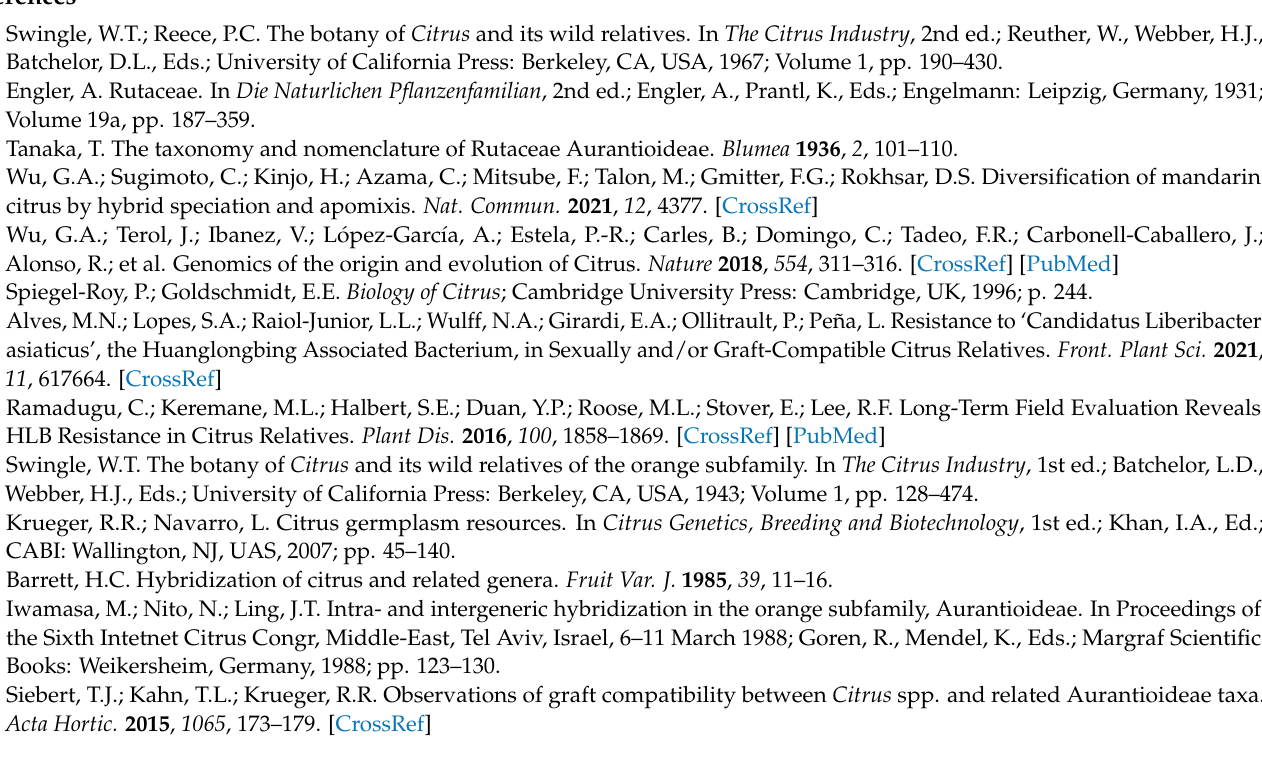
grafting. Figure S2: Plants of (left) Rangpur lime grafted on Clausena lansium , and (right) Clausena lansium grafted on Rangpur lime 12 months after transplanting into the field. Figure S3: Twelve years-old Clausena lansium mother trees did not show visual HLB symptoms in field cultivation